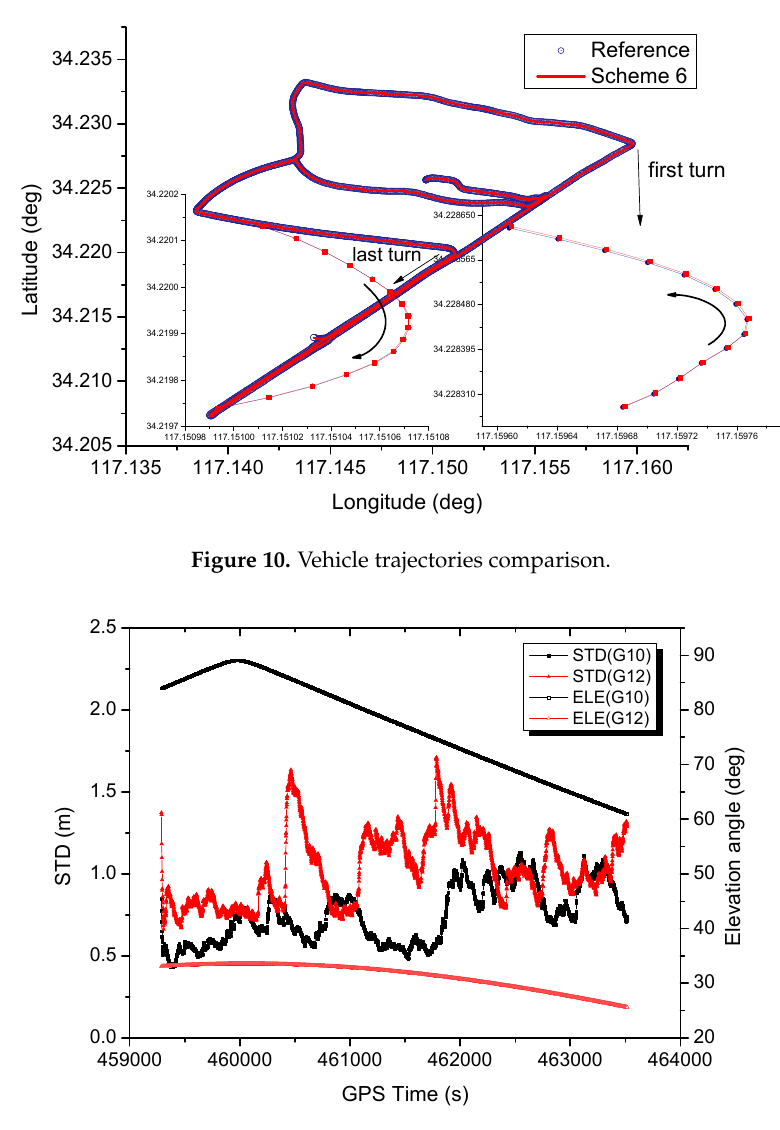
Figure 9. 3D position difference for different schemes.